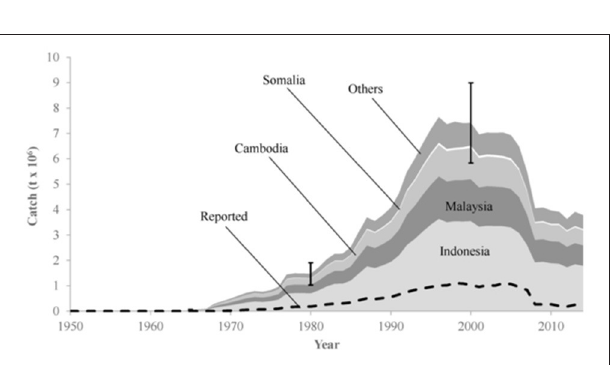
FIGURE 2 | Reconstructed total catches for Thailand for 1950–2014 (catches within and outside of Thailand’s EEZ), showing contributions of different fisheries sectors. Reported landings data are overlaid as a dashed line.